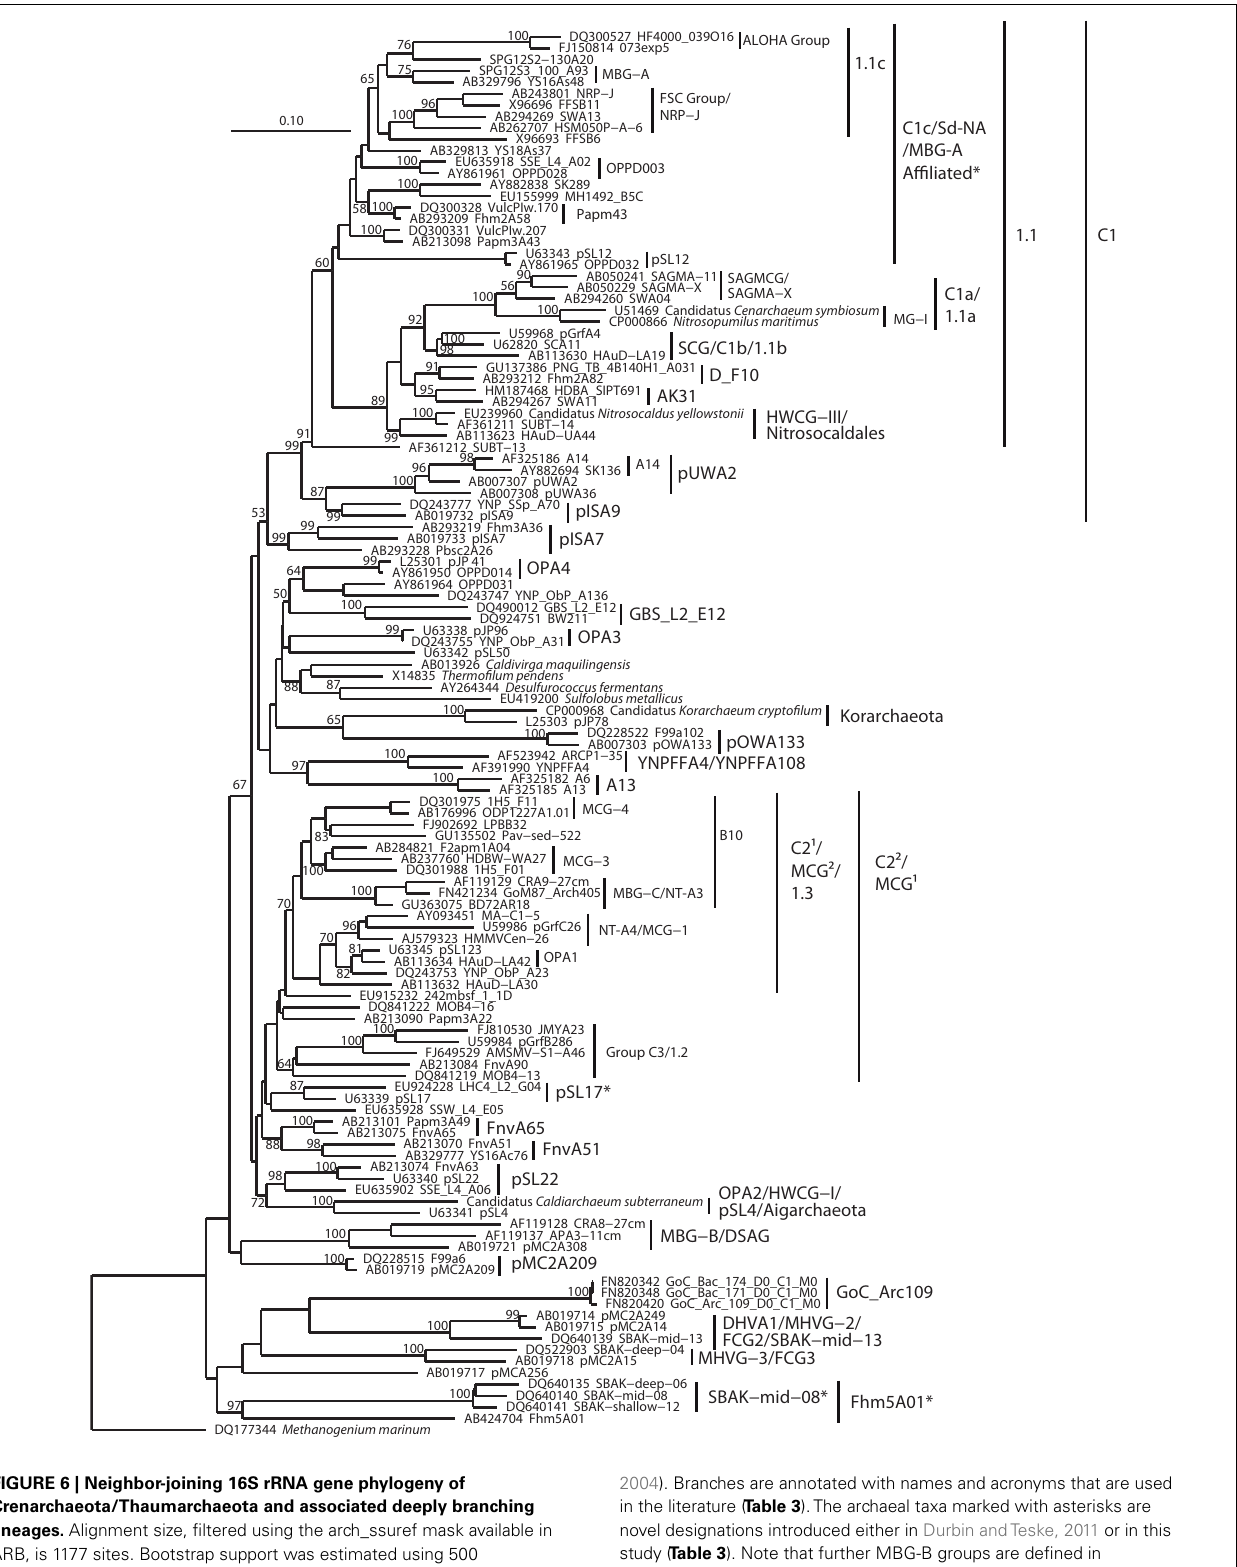
2004). Branches are annotated with names and acronyms that are used in the literature ( Table 3 ).The archaeal taxa marked with asterisks are novel designations introduced either in Durbin andTeske, 2011 or in this study ( Table 3 ). Note that further MBG-B groups are defined in Robertson et al.